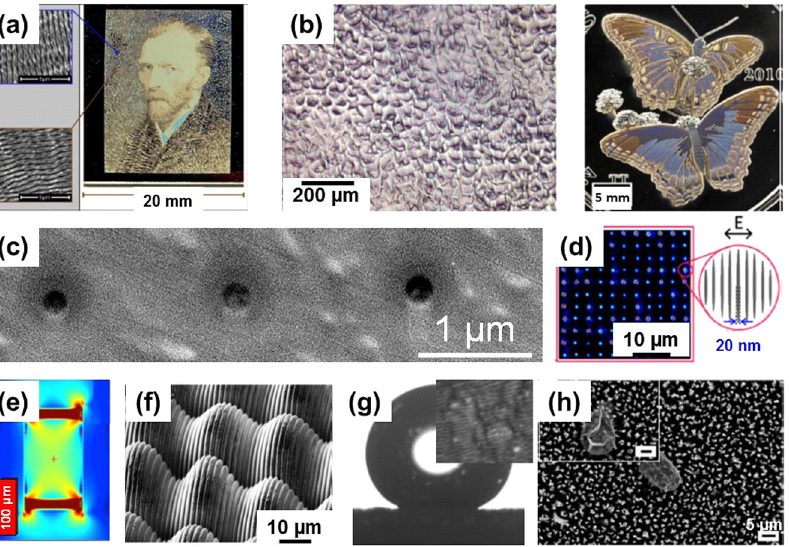
Figure 11: Functionalities of laser-induced nanostructures.